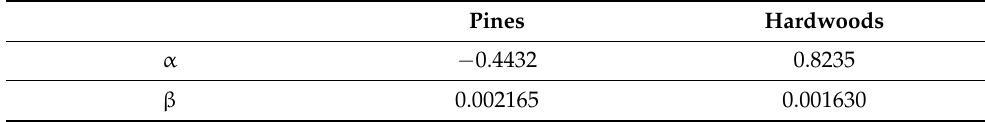
Table 2. Species-specific parameters for calculating volume.